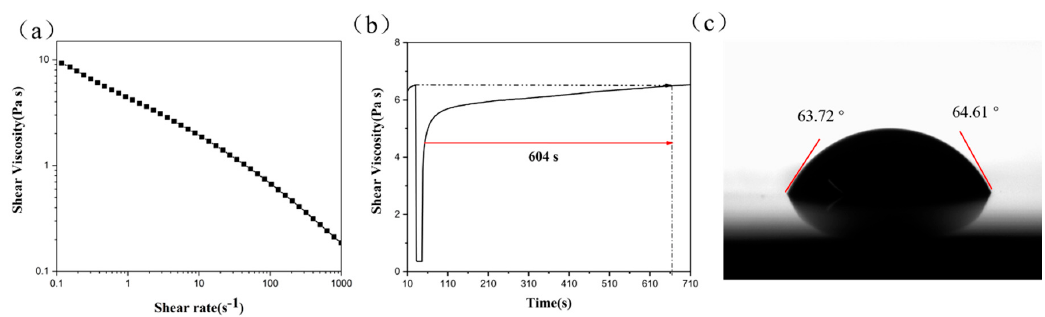
Figure 7. ( a ) Rheological curve, ( b ) thixotropy curve, and ( c ) contact angle of the oxygen indicator solution.